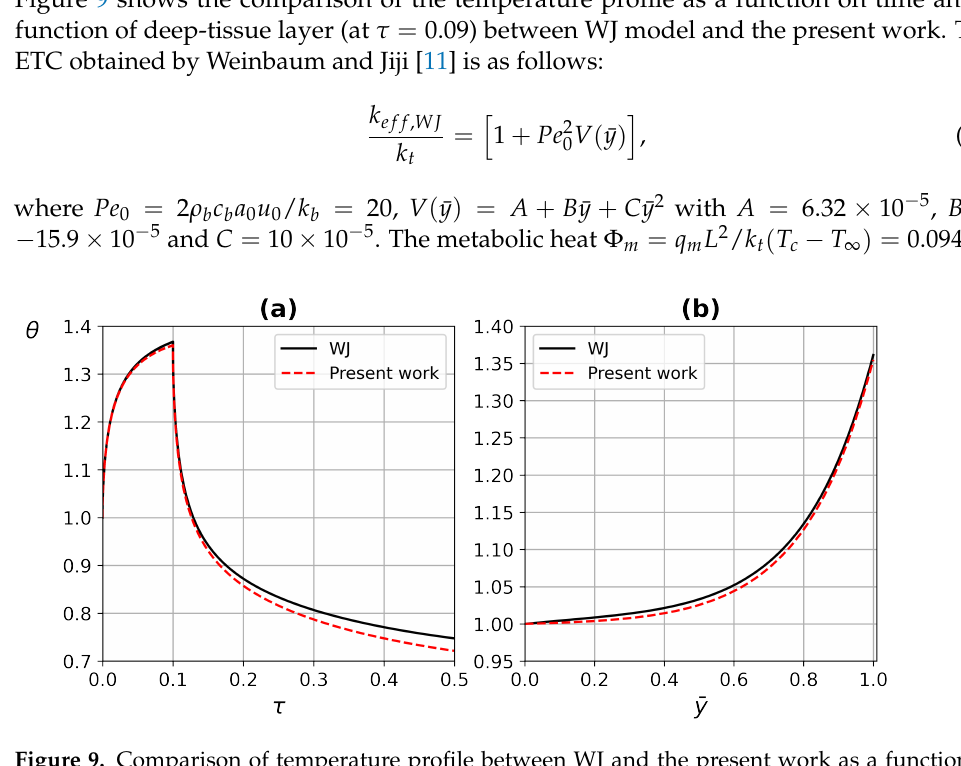
Figure 9. Comparison of temperature profile between WJ and the present work as a function of ( a ) time, and ( b ) tissue layer depth.